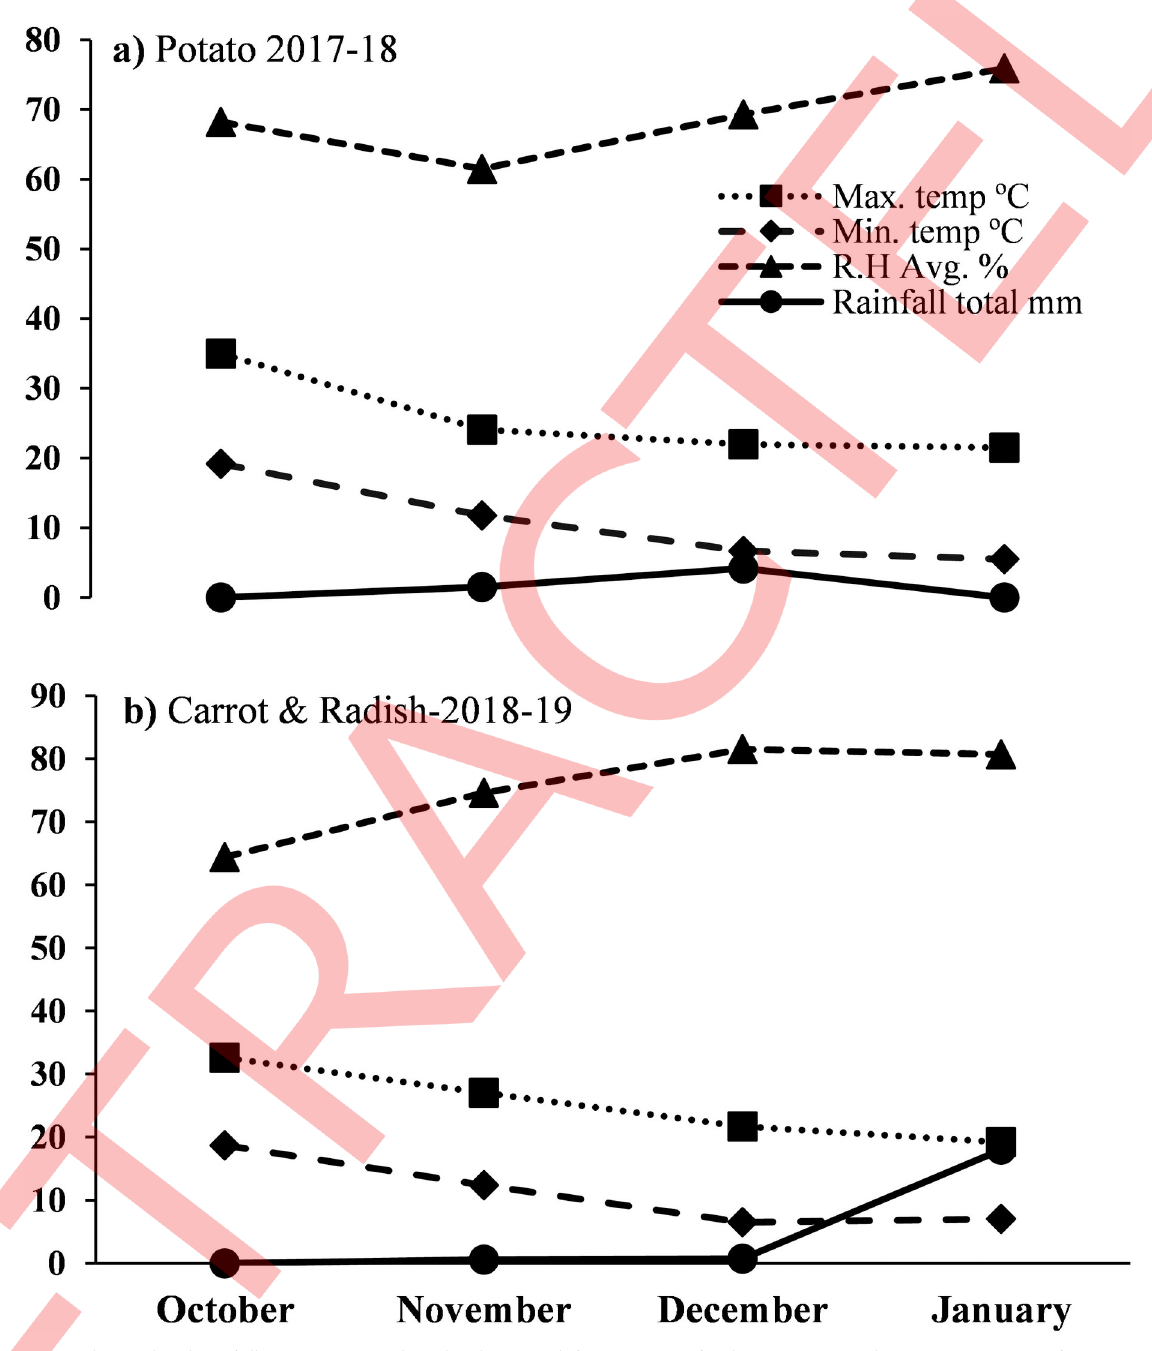
Fig 1. The weather data of all experiments conducted at the research farm Institute of Soil & Environmental Sciences, University of Agriculture Faisalabad, Pakistan, where a) shows weather data during potato experiment, whereas b) shows the weather data during carrot and radish experiment. Carrot and radish were grown simultaneously in consecutive